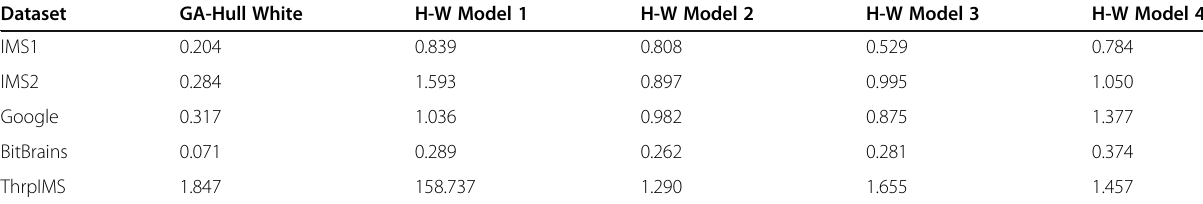
Table 5 Average std. of MAPE based on 10 simulations